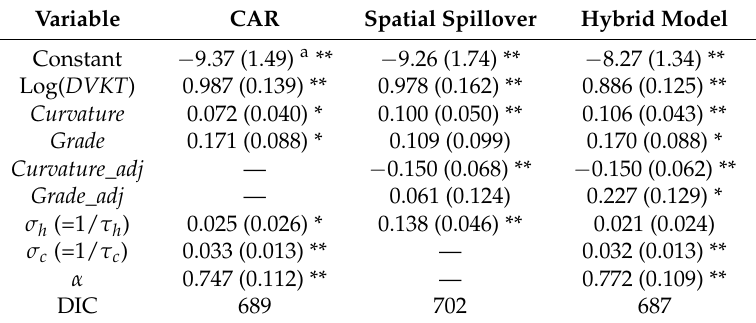
Table 2. Estimation results for the spatial